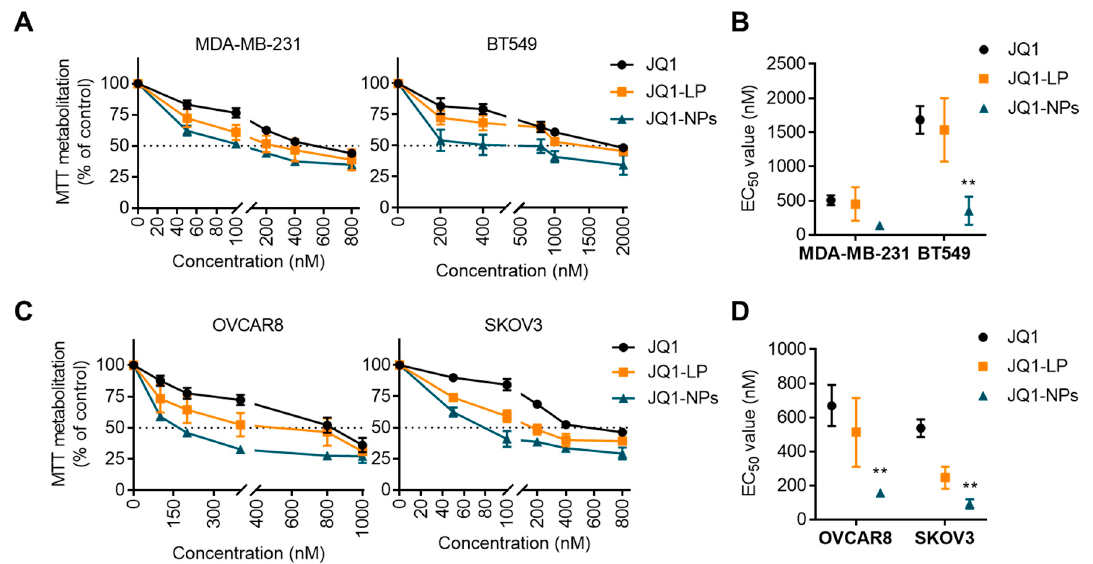
Figure 3. The effect of JQ1 nanocarriers in TNBC and ovarian cancer cell lines. Dose–response curves comparing JQ1 free, JQ1-LP and JQ1-NPs in MDA-MB-231 and BT549 (TNBC) cell lines ( A ) and OVCAR8 and SKOV3 (ovarian cancer) cell lines ( C ). Cells were seeded in p48 plates (5000 cells/well) and treated for 72 h with indicated doses of compound. EC 50 values calculated by interpolation using GraphPad Prism 7.0 software shown in ( B ) (TNBC) and ( D ) (ovarian cancer). Statistical analysis between control JQ1 versus JQ1-LP or JQ1-NPs are shown. ** p ≤ 0.01.